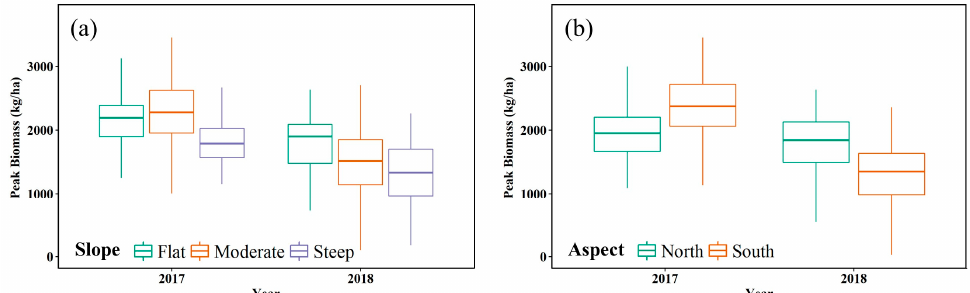
Figure 11. Variation of the predicted peak biomass by ( a ) slope and ( b ) aspect. The area was divided into three categories of slopes: flat terrain (0~5 ◦ ), moderate (5~15 ◦ ), and steep (>15 ◦ ).